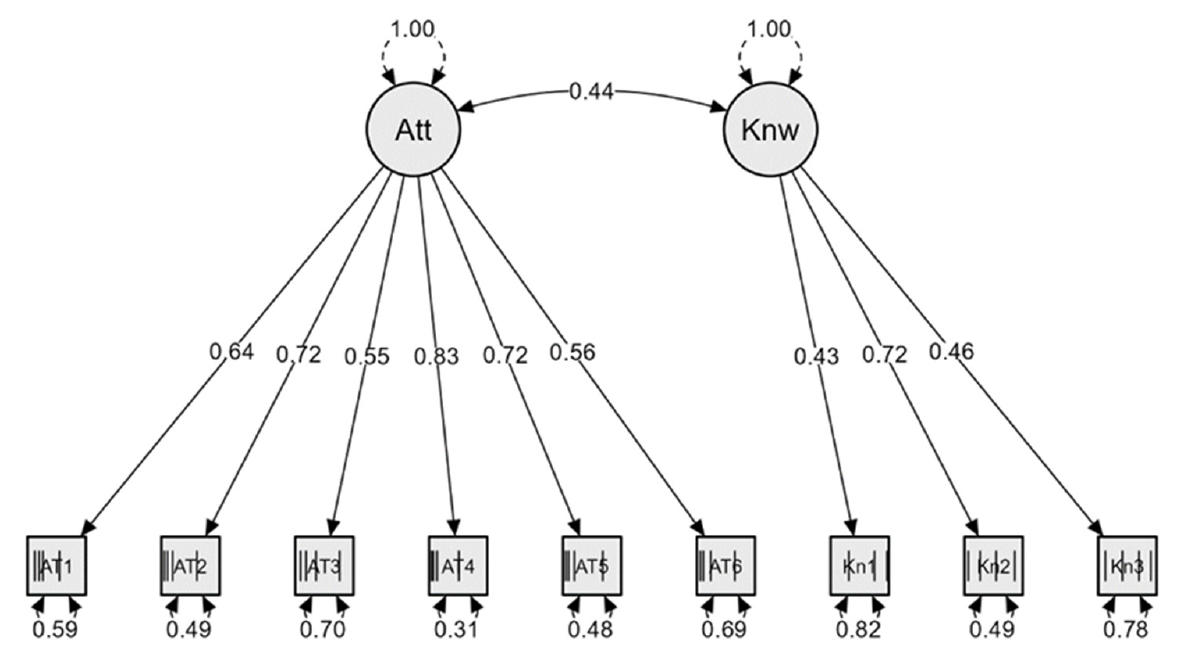
Figure 3. Factor loadings for the area of information literacy. Factor loadings for the security area ranged from 0.47 to 0.74, which is considered acceptable and significant (Figure 4).